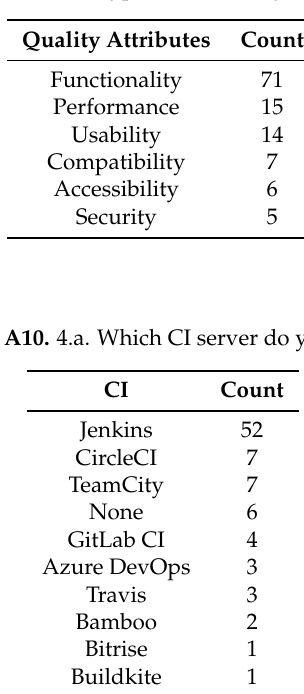
Table A9. 3.c. Which type of test(s) do you